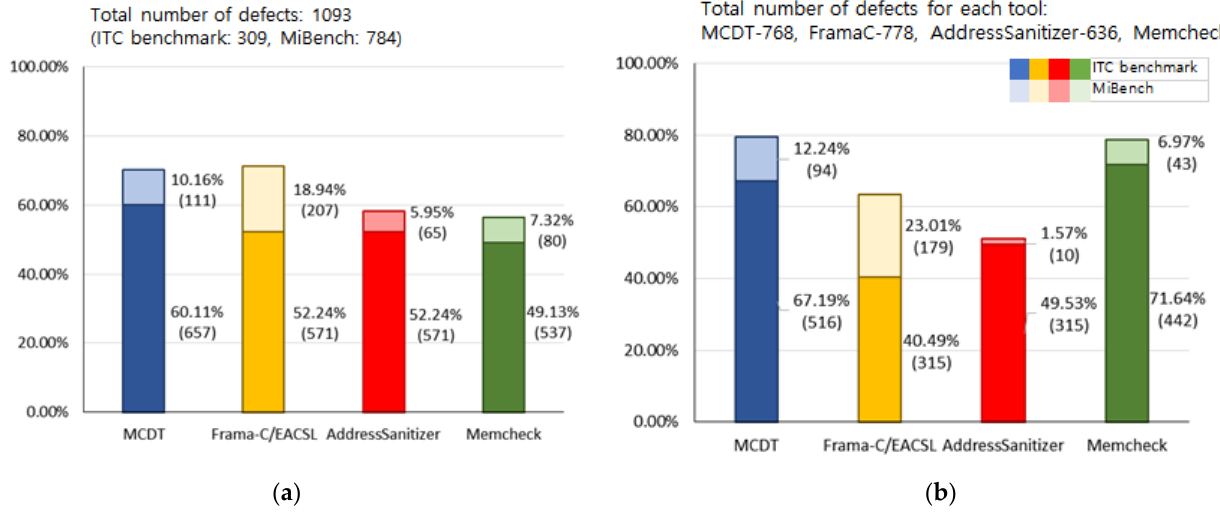
Figure 14. Effectiveness of detecting memory defects when a crash occurred; ( a ) defect-detection rate; ( b ) defect-cause accuracy.